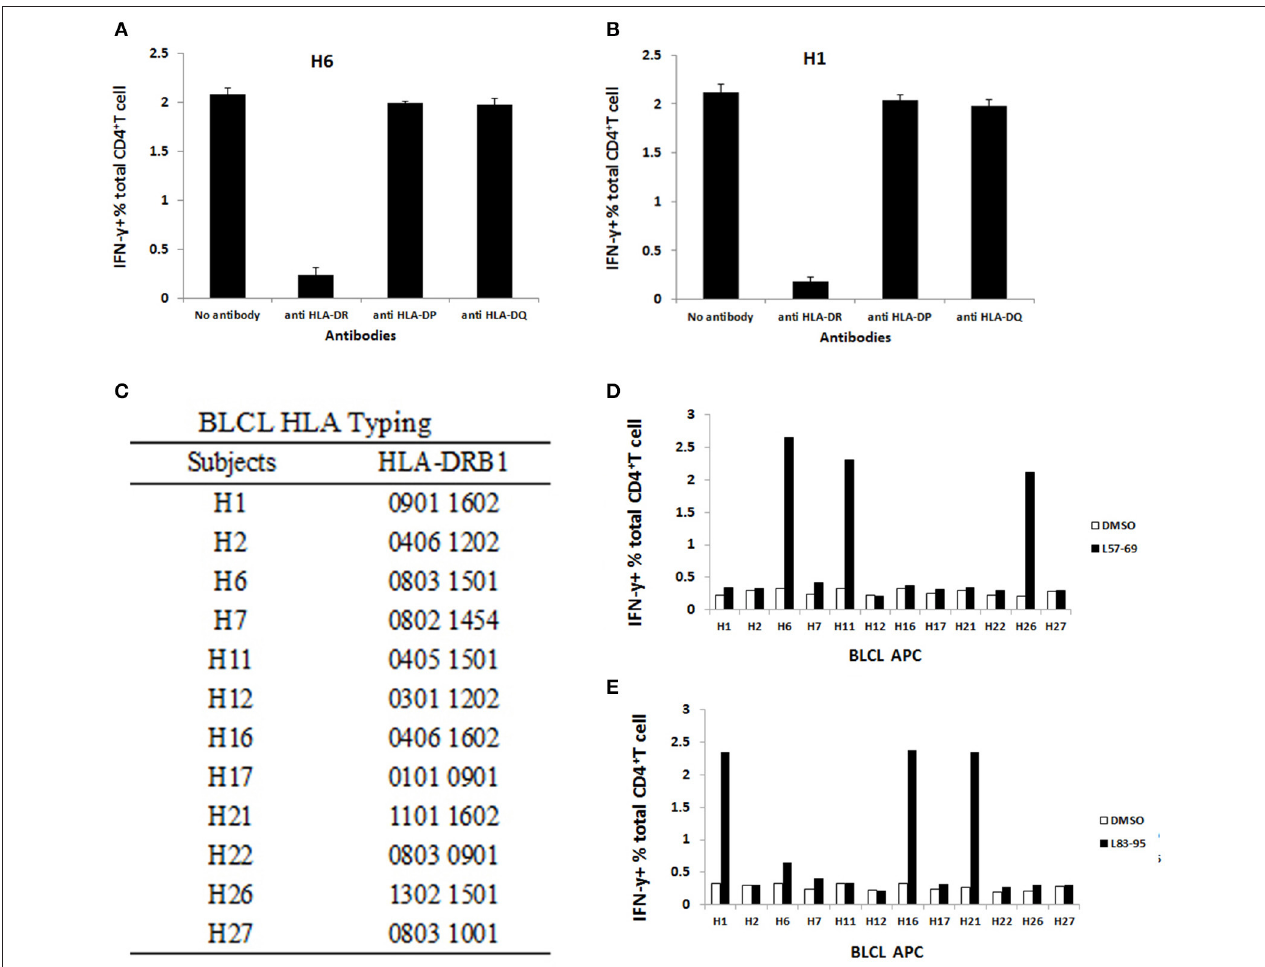
FIGURE 5 | Peptides alone or in presence of blocking antibodies against HLA-DR, HLA-DP, or HLA-DQ. HLA-II antibodies were used to identify the HLA locus presenting the L 57 – 69 (A) and L 83 – 95 (B) 13mer peptide. The results were shown as average frequency ± standard deviation ( n = 3). Only anti-HLA DR antibodies abrogated the responses, demonstrating that the responses to L 55 – 69 and L 83 – 95 are MHC Class II restricted. (C) A panel of B-LCLs with different DR types was identified. HLA-matched B-LCLs were used to further identify the HLA molecule presenting the 13mer peptide L 57 – 69 (E) and L 83 – 95 (D) .